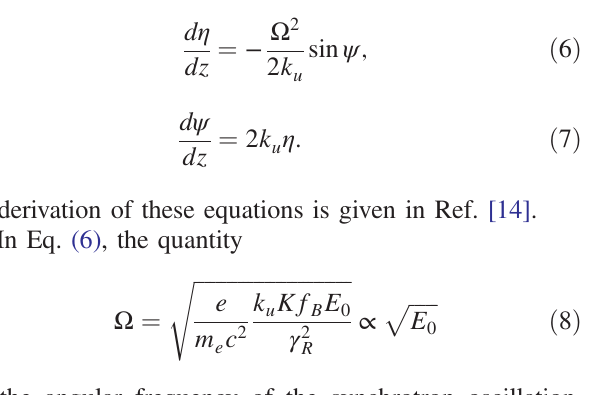
FIG. 2. The longitudinal phase space ð ψ ; η Þ , with electron trajectories shown by the blue curves. The red curve is the separatrix , and the region enclosed by it is the ponderomotive bucket . The straight lines η ¼ 0 and ψ ¼ 0 divide the space into four quadrants, as indicated by the Roman